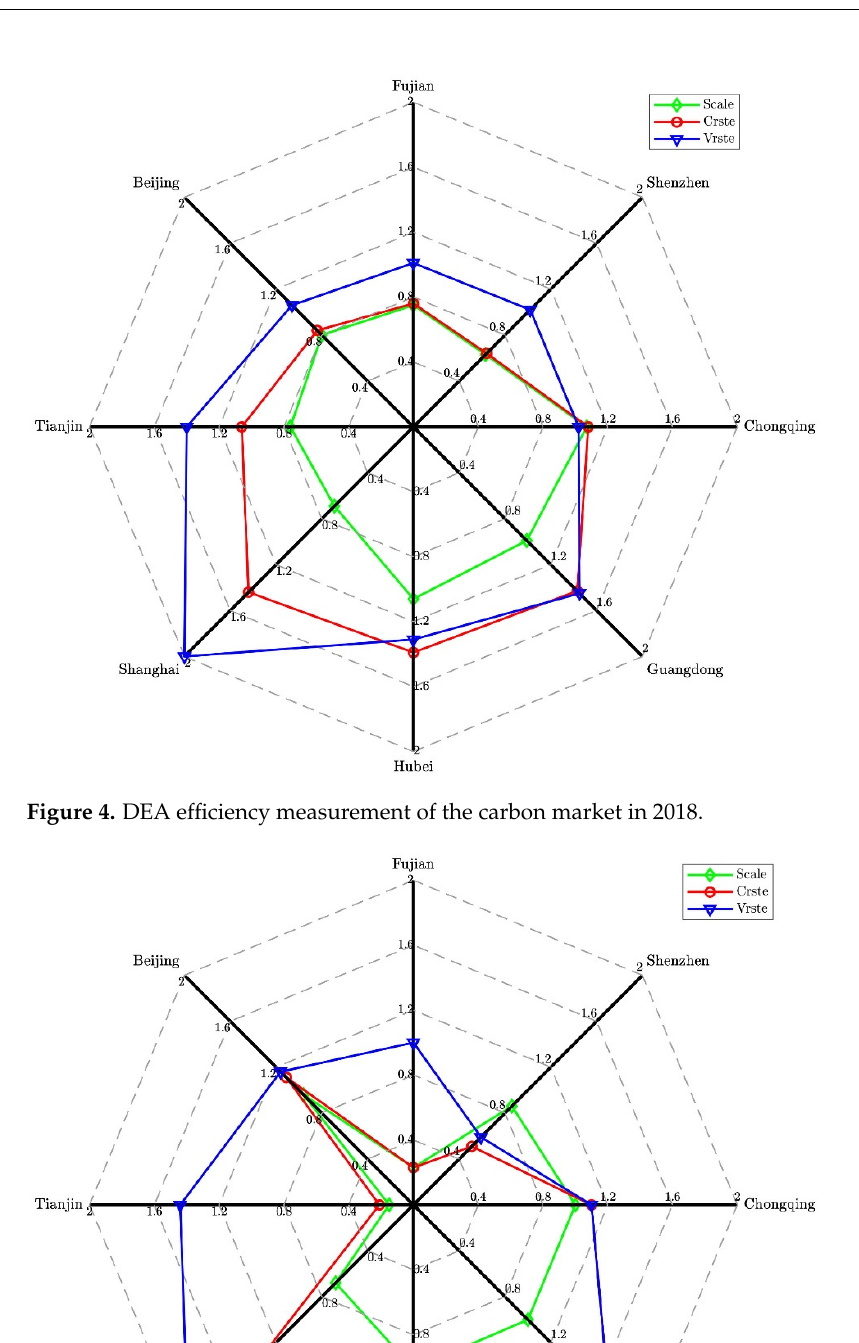
Figure 3. DEA efficiency measurement of the carbon market in 2017.